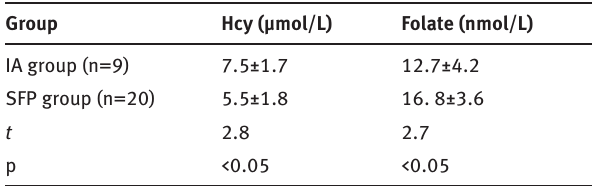
Table 4: Serum Hcy and folate comparison between control and case group ( sx ±